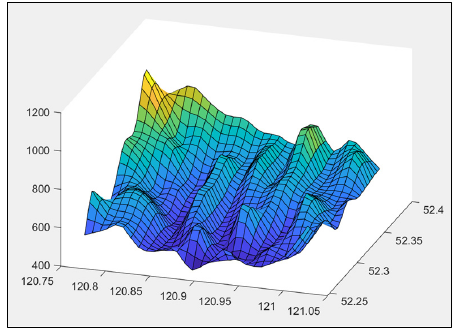
Figure 5. 3D spatial topographic map.